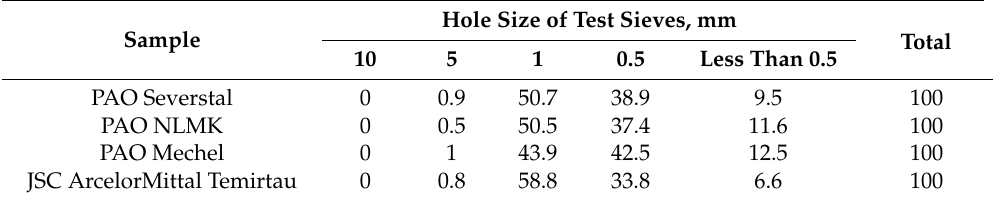
Table 3. Fractional composition of granulated blast furnace slags from the calibration